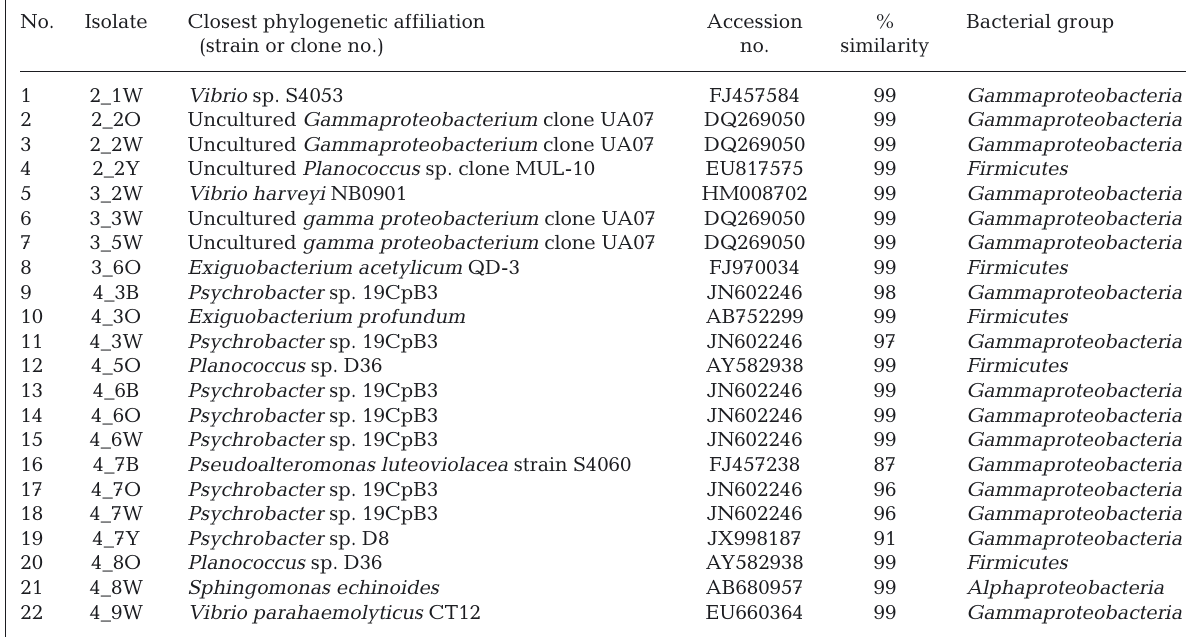
Table 1. Phylogenetic affiliations of bacteria isolated from the sea cucumber, Stichopus badionotus . The 16S rRNA gene sequences of individual bacterial isolates were compared to the sequences deposited in GenBank. The closest phylogenetic affiliation for each marine isolate is indicated by strain name, accession number, similarity, bacterial group and